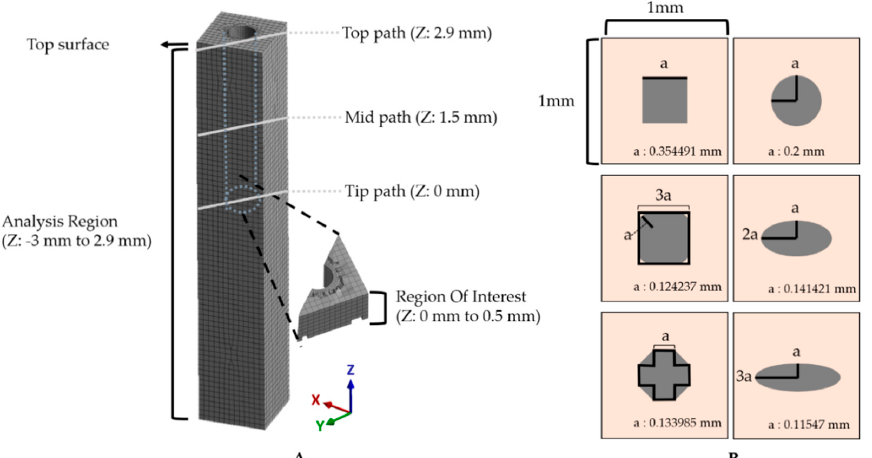
Figure 4. Method for assessment of simulation results. ( A ) The maximum and averaged equivalent strain versus time were investigated in the ROI (500 μ m from the tip). Gray solid lines represent three paths: top (Z: 2.9 mm), mid (Z: 1.5 mm), and tip (Z: 0 mm). ( B ) Various cross-sections of the probe. The outer lightly colored square is a cross-section of the brain tissue model, and the inner shapes depict various designs; ellipses with an aspect ratio of 1:1/1:2/1:3, square, rounded square, and octagon. These are all designed to have an area of S = 0.04 π μ m 2 as informed with the value of “a.”